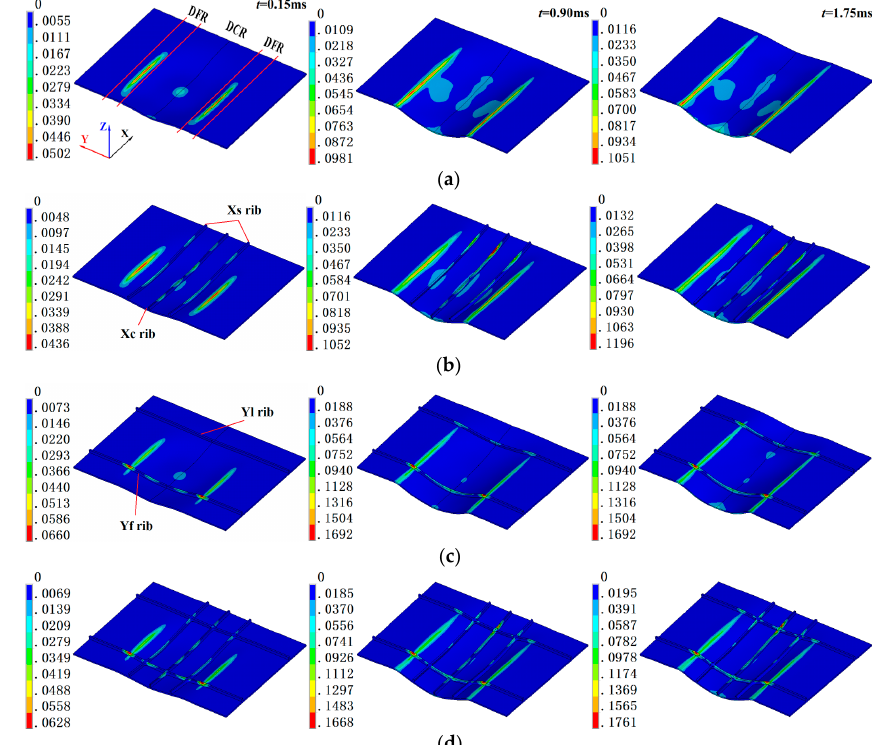
Figure 13. Equivalent plastic strain distribution of four panels in the early stage of each discharge: ( a ) FP; ( b ) XP; ( c ) YP; and ( d ) GP. ( a ) FP; ( b ) XP; ( c ) YP; and ( d )